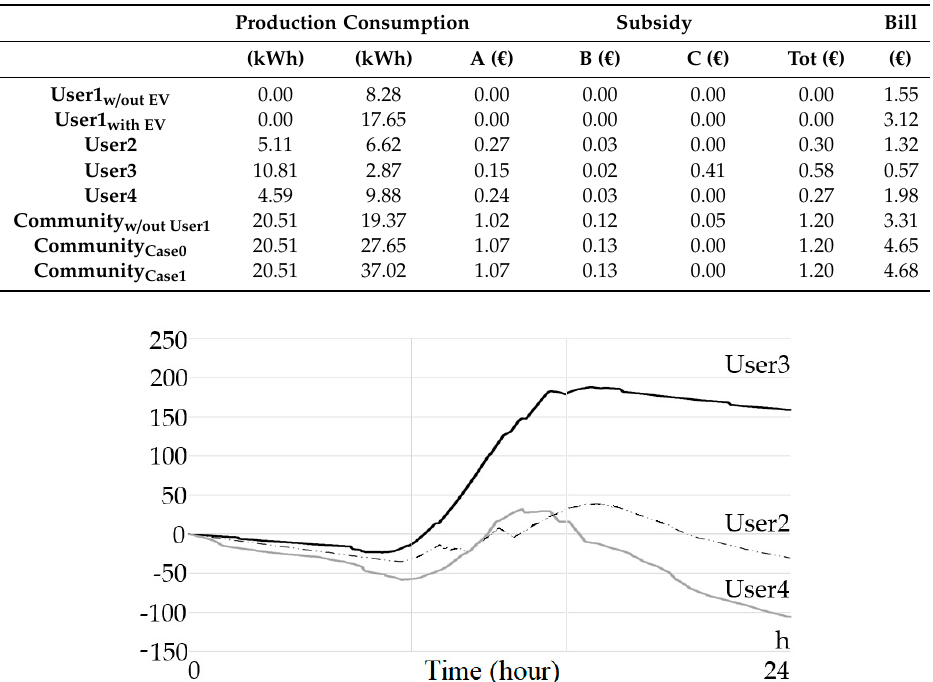
Table 3. Subsidies and bills.